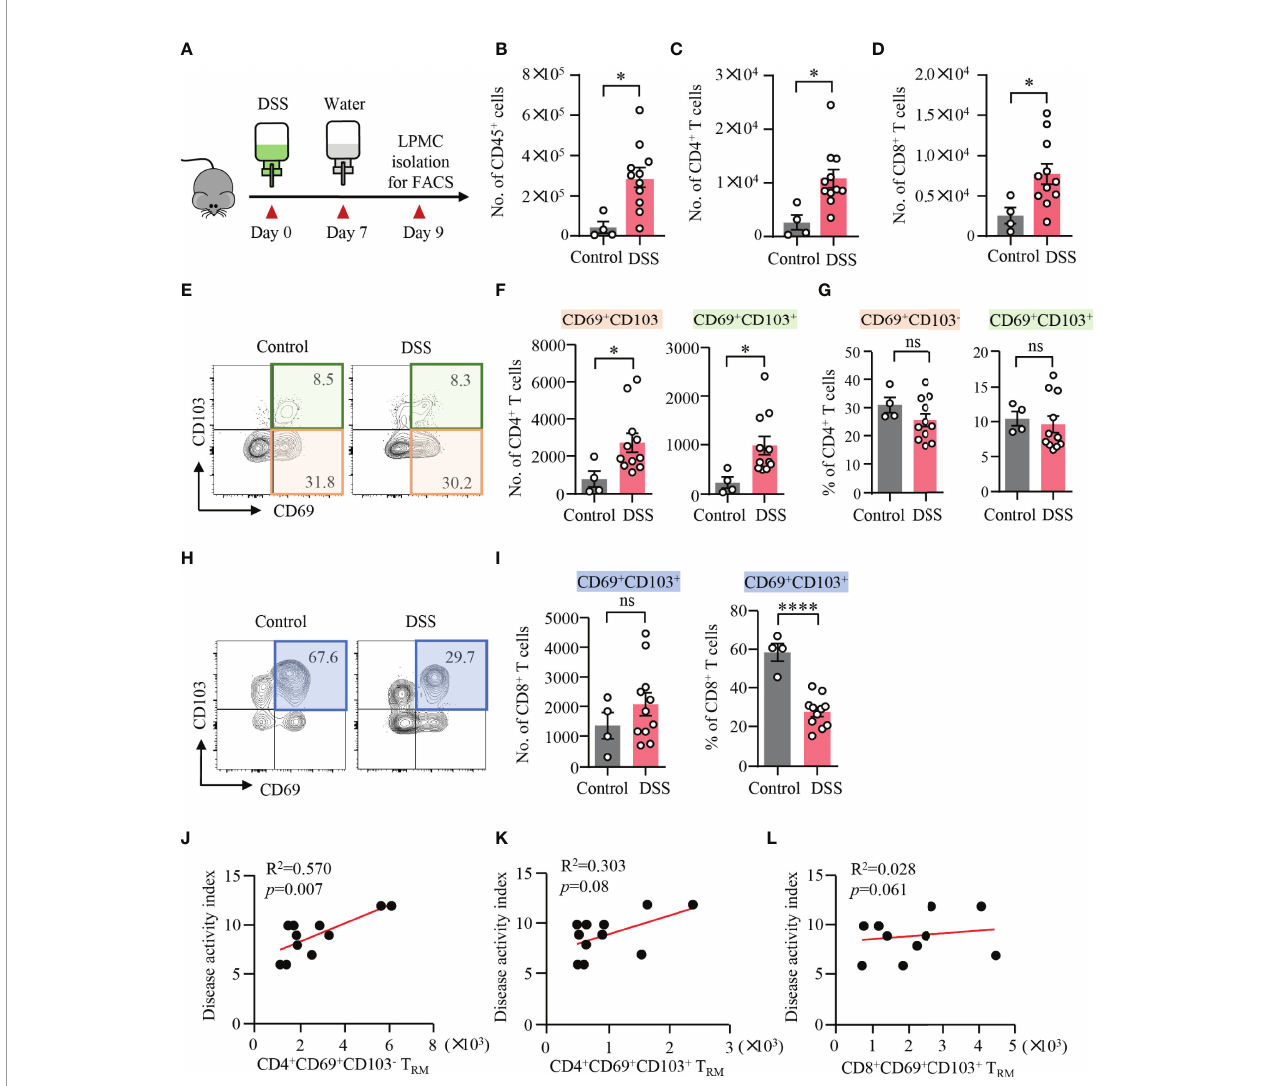
FIGURE 1 | Expansion of CD4 + T RM cells in DSS-induced colitis. (A) Schematic representation of mouse experiment. Eight-week-old mice were fed with or without DSS for 7 days and switched to water for another 2 days. Disease activities were monitored daily. (B – L) Colons were collected from mice with or without DSS- induced colitis. Single cells were prepared and lamina propria mononuclear cells (LPMCs) were isolated. The cell subsets were measured by fl ow cytometry. (B) Numbers of CD45 + cells. (C) Numbers of CD4 + T cells. (D) Numbers of CD8 + T cells. (E) Representative counter plots for CD69 and CD103 expression in CD4 + T cells. (F) Numbers of CD4 + CD69 + CD103 − T cells or CD4 + CD69 + CD103 + T cells measured by fl ow cytometry. (G) Percentages of CD4 + CD69 + CD103 − T cells or CD4 + CD69 + CD103 + T cells measured by fl ow cytometry. (H) Representative counter plots for CD69 and CD103 expression in CD8 + T cells. (I) Numbers and frequency of CD8 + CD69 + CD103 + T cells measured by fl ow cytometry. (J – L) Correlations between the numbers of CD4 + CD69 + CD103 − T cells, CD4 + CD69 + CD103 + T cells, and CD8 + CD69 + CD103 + T cells with disease activity index in DSS-induced colitis. Spearman ’ s R square and a regression line are indicated. n = 4 in the control group and n = 11 in the experiment group. Data are means ± SEM. * p < 0.05, **** p < 0.0001 by Student ’ s t -test. ns, not signi fi